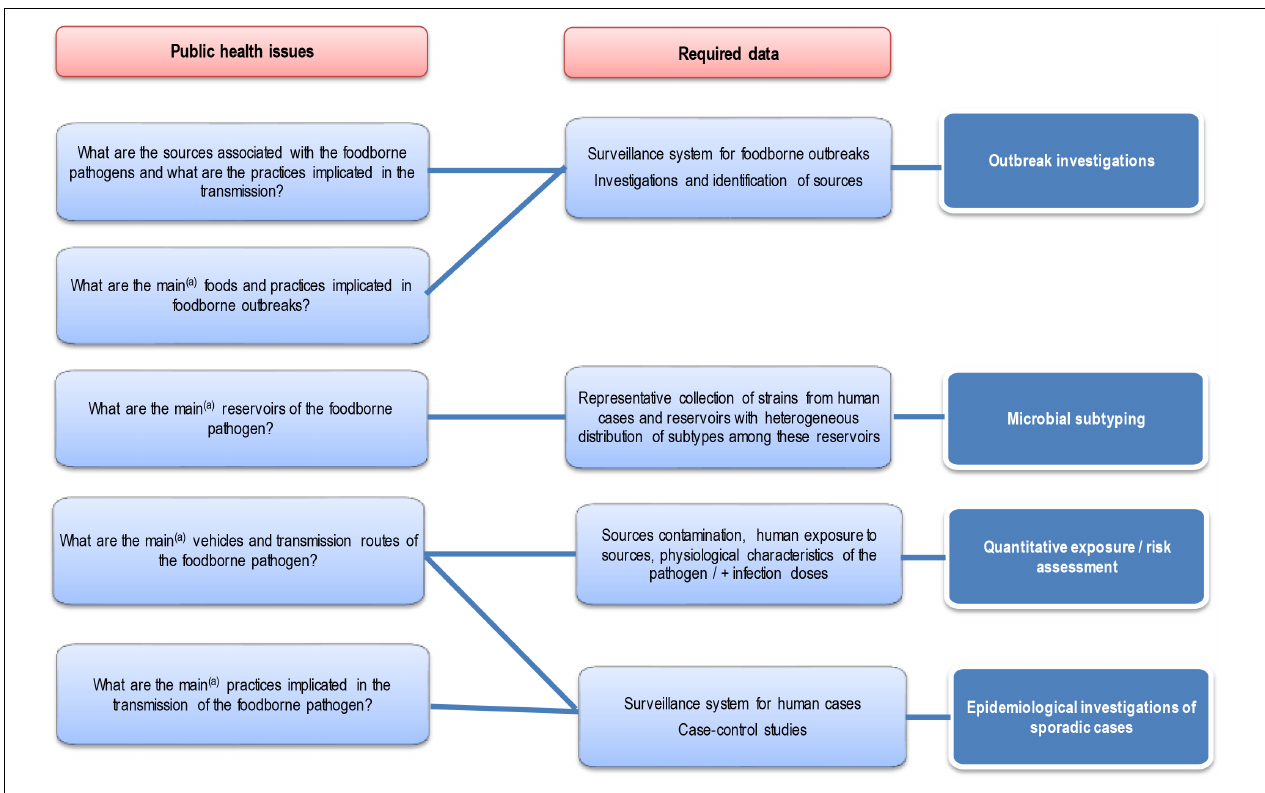
FIGURE 5 | Preferential choice of source attribution methods based on public health issues. ( a ) Ranking and/or quantifying the relative